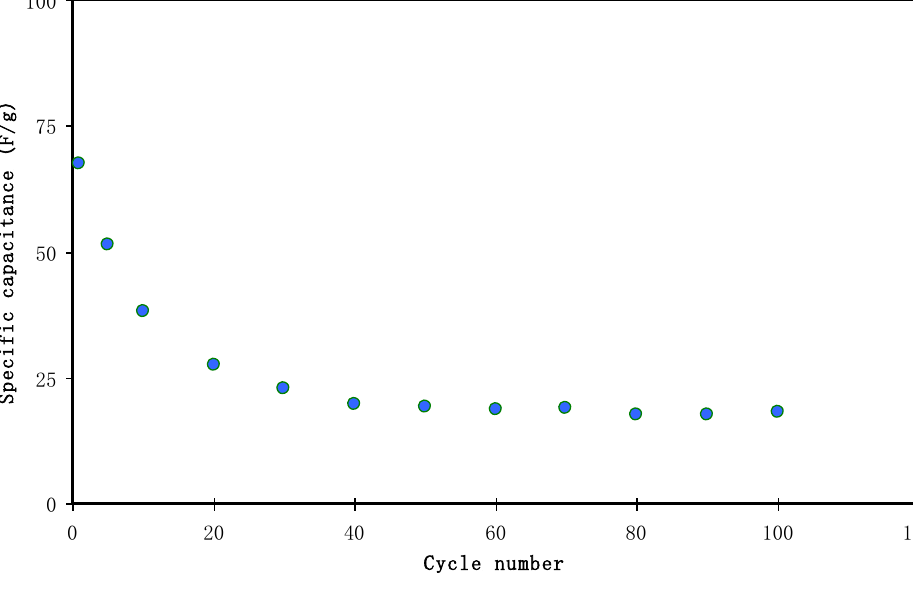
Figure 10. Charge-discharge profile for the fabricated EDLC at 0.5 mA / cm 2 . Table 2. Carbon-based EDLC studies.